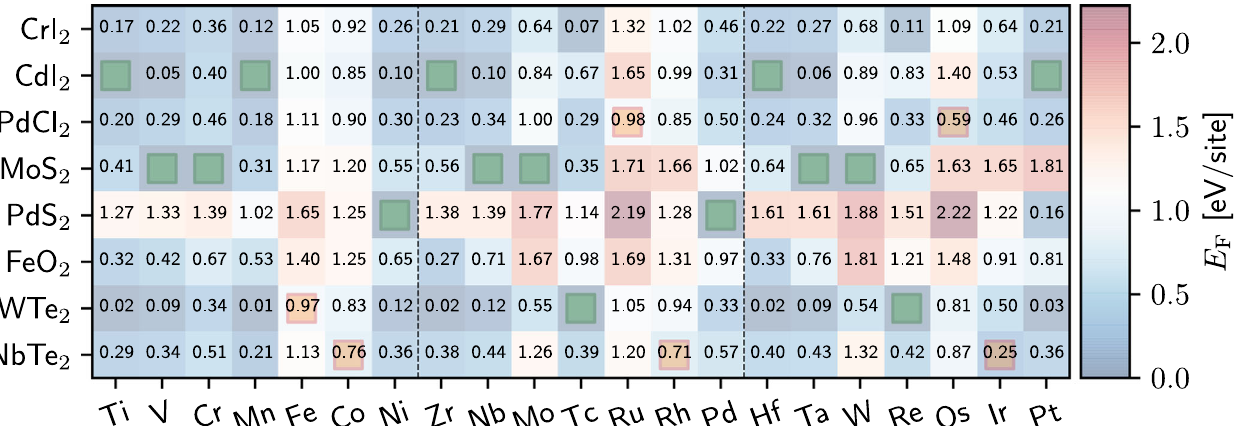
Fig. 2 Lattice stability. Lattice stability of M S 2 compound in the prototypes shown in Fig. 1b – f according to Eq. (1), M being one of the metals highlighted in Fig. 1a. The colorbar on the right reports the energy above the ground state in eV over lattice sites. Green squares mark GS prototypes, de fi ned by E F = 0. Orange squares mark the lowest-energy 2D prototype of transition metals displaying a 3D GS (grey boxes in Fig. 1a). Vertical dashed black lines separate rows of the periodic table, see Fig.